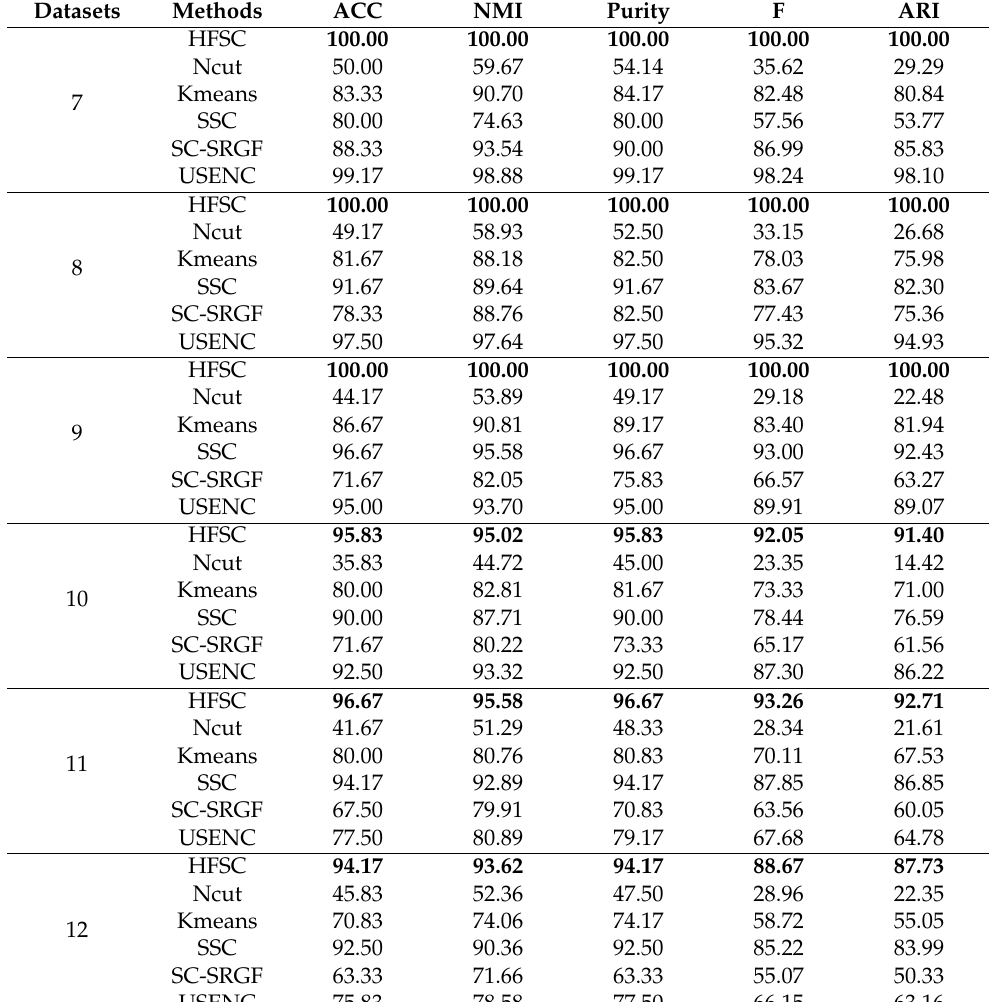
Table 3. The clustering performances of the proposed approach and the comparison methods for the simulated datasets (7 ∼ 12). The bold denotes the best